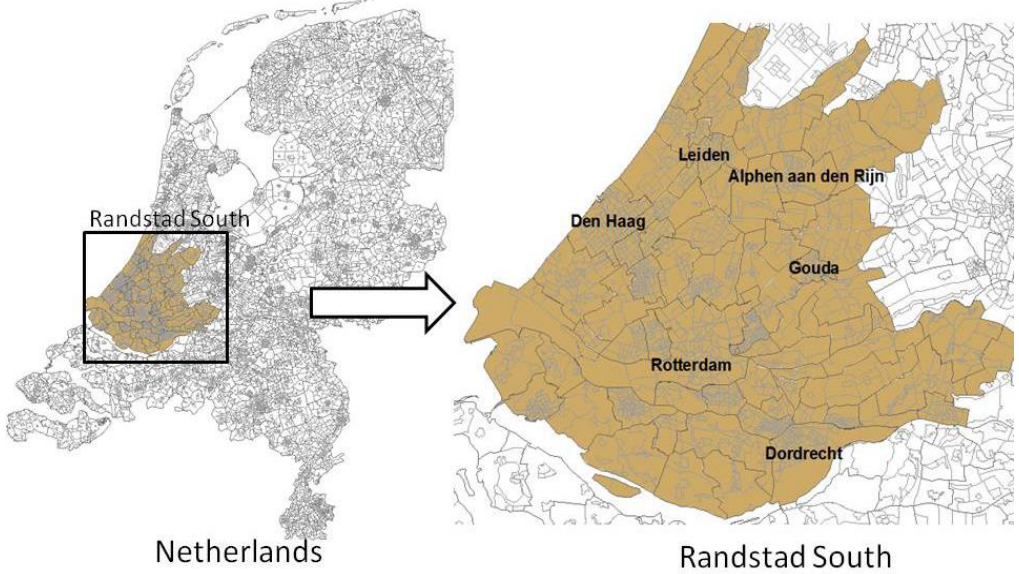
Figure 1. Study area Randstad South